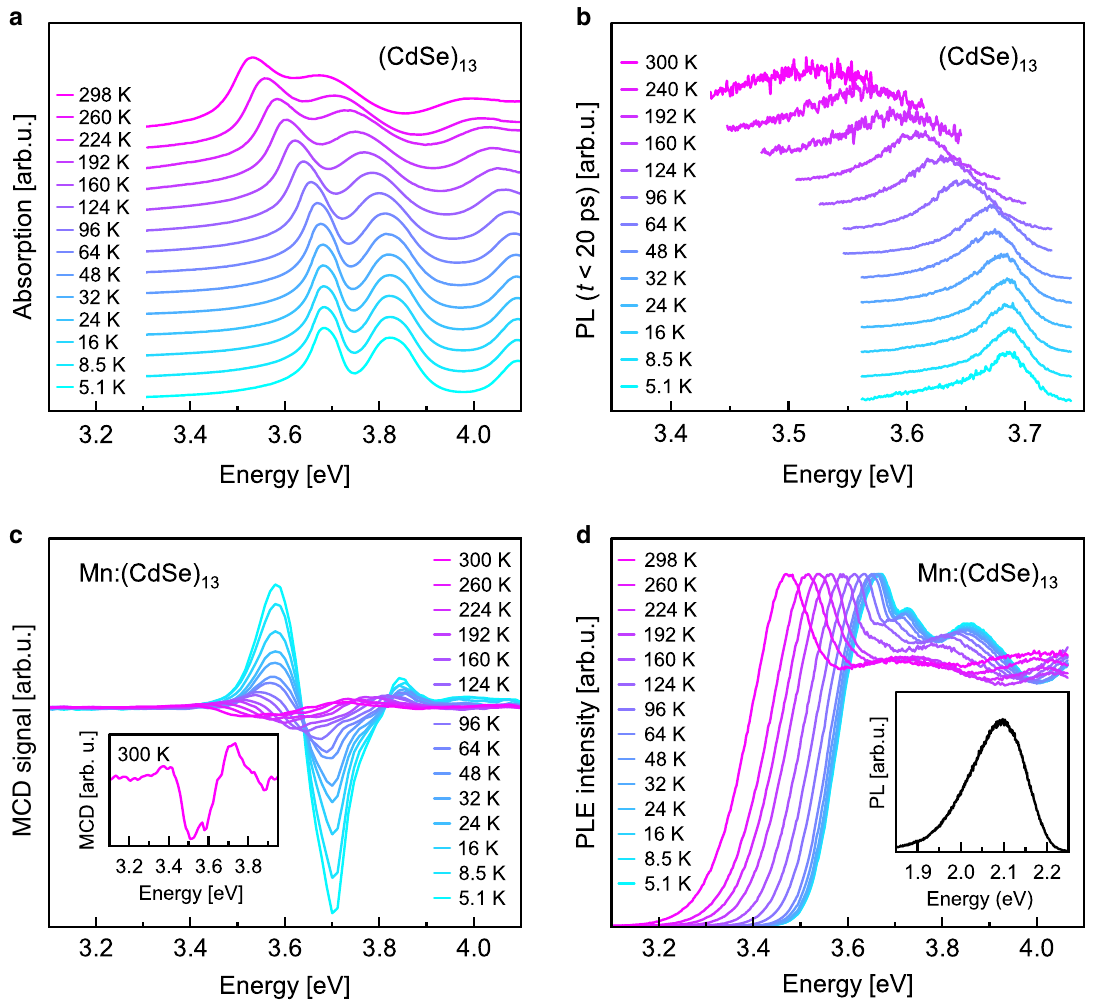
Fig. 1 Temperature dependent bandgap shift in undoped as well as doped CdSe magic sized cluster (MSC). a Absorption and b short-time photoluminescence (PL), measured between 5 K and 300 K. c , d Temperature dependence of the bandgap in Mn 2 + -doped (CdSe) 13 MSCs using optical signatures introduced by the magnetic dopants. c Magnetic circular dichroism (MCD) spectra of Mn:(CdSe) 13 MSCs at 1.6 T between 5.2 and 300 K. The signals allow tracking of the bandgap shift with temperature by monitoring the energetic position of the fi rst zero-crossing. d, Photoluminescence excitation (PLE) spectra probed at the 4 T 1 → 6 A 1 Mn 2 + internal emission between 5.2 and 300 K. The inset depicts the time integrated PL signal of Mn 2 + -doped (CdSe) 13 MSCs revealing the speci fi c orange Mn 2 + luminescence, used for probing bandgap states in PLE